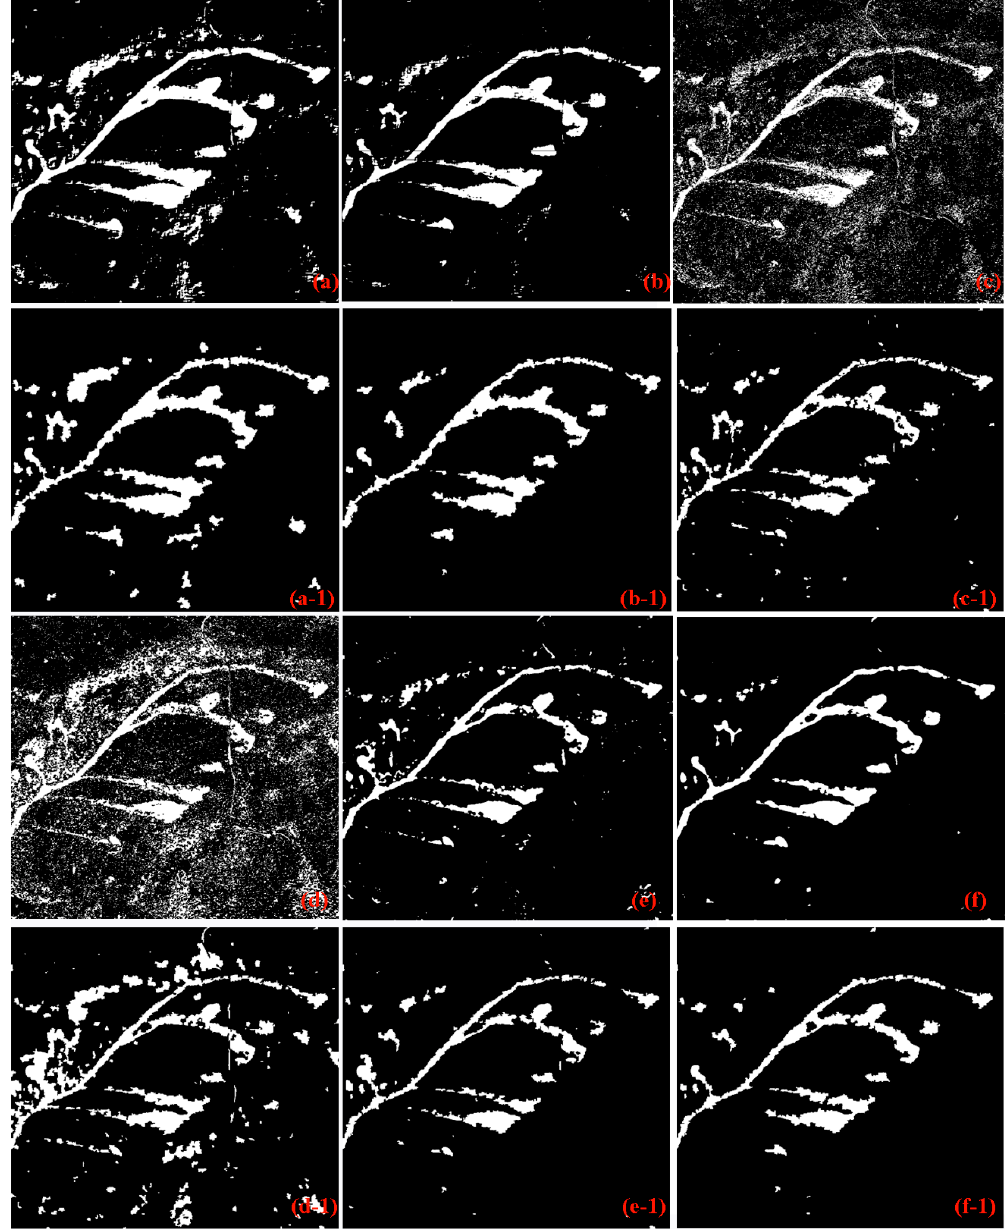
Figure 7. LCCD maps obtained by the preprocessing methods and the proposed OBEM approach for the first data set: ( a ) GWDM_EM; ( b ) GWDM_FCM; ( c ) CVA_EM; ( a-1 ) GWDM_EM+OBEM; ( b-1 ) GWDM_FCM+OBEM; ( c-1 ) CVA_EM+OBEM; ( d ) MRF_EM; ( e ) LSELUC; ( f ) PCA_Kmeans; ( d-1 ) MRF_EM+OBEM; ( e-1 ) LSELUC+OBEM; and ( f-1 ) PCA_Kmeans+OBEM.